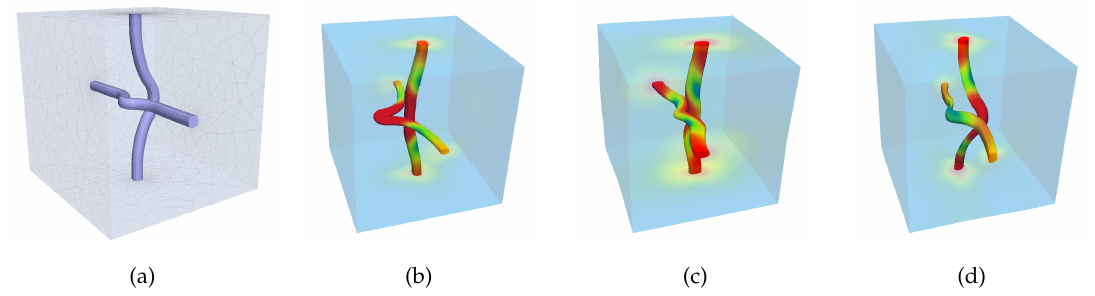
Figure 5. ( a ) fibrous microstructure. ( b – d ) random F -reduced basis (RB)